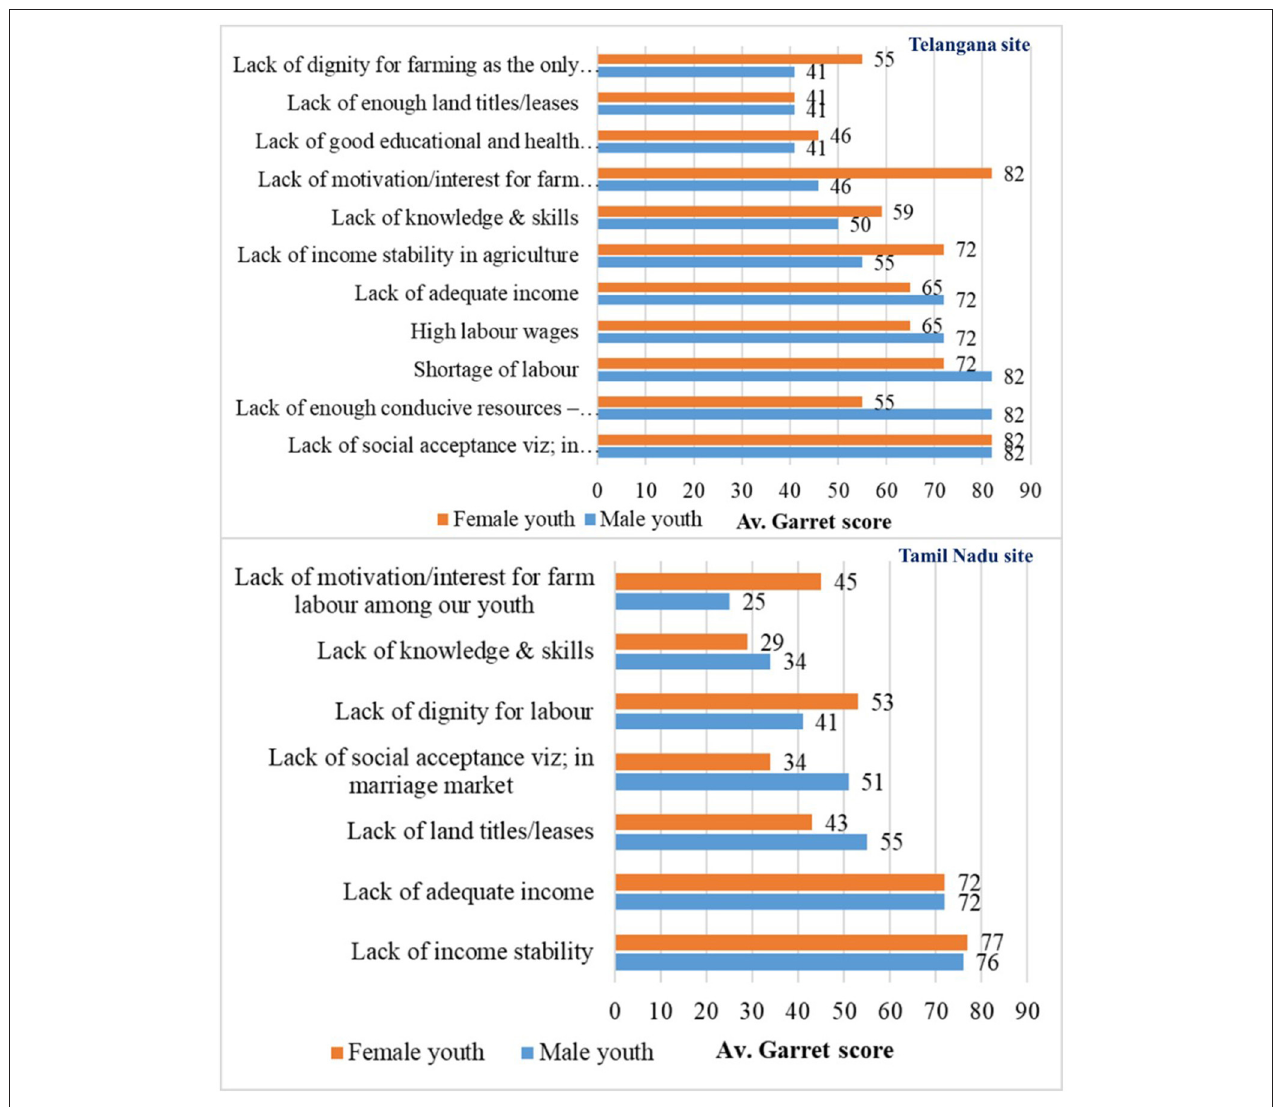
FIGURE 8 | Challenges confronting rural youth in the pursuit of family farming in Telangana and Tamil Nadu.